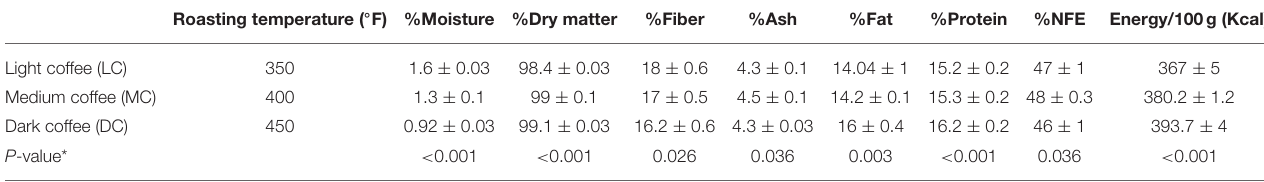
TABLE 1 | Nutritional values of the coffee roast extracts.